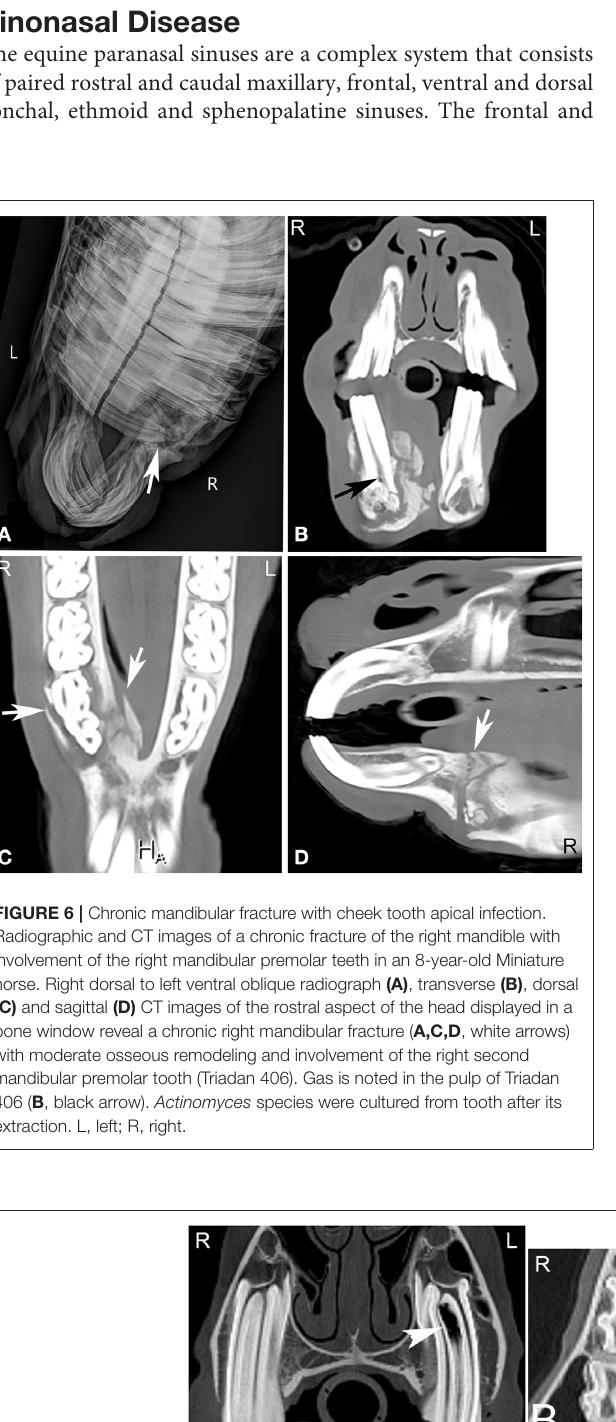
Frontiers in Veterinary Science |